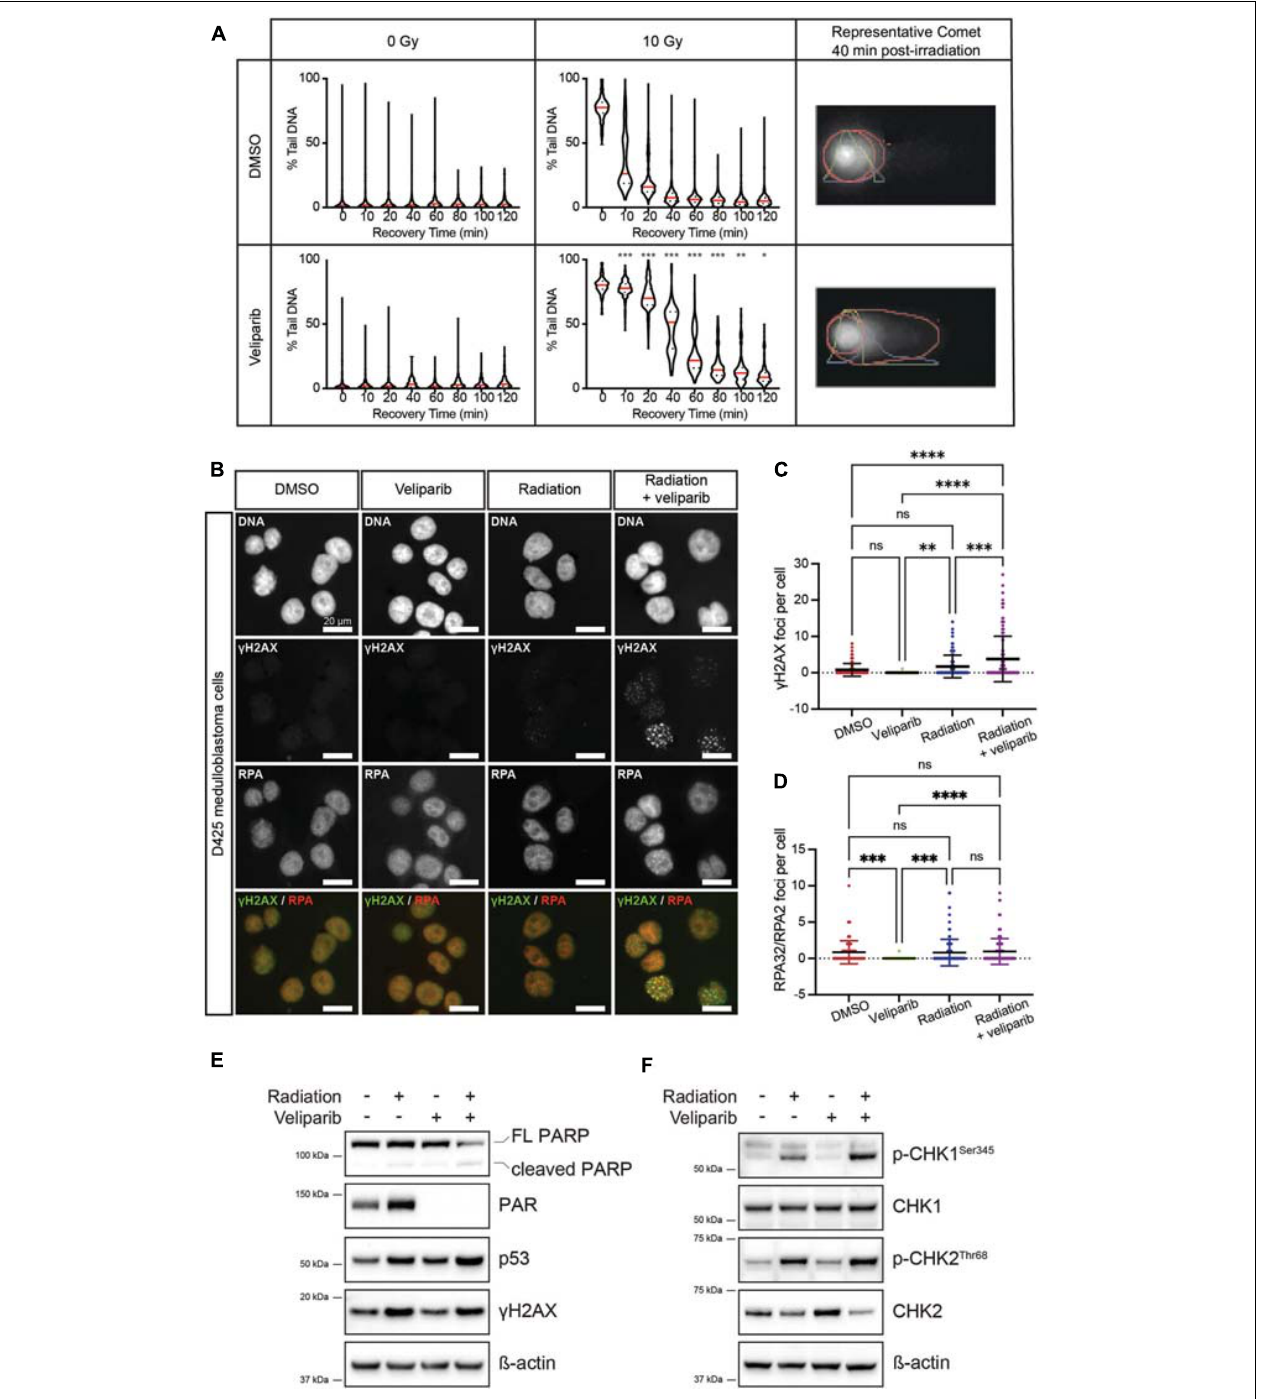
FIGURE 1 | PARP inhibition reduces the repair rate of radiation-induced DNA damage. (A) Comet assays were performed to detect DNA damage post-irradiation. Violin plots showing DNA damage (measured as the percent of DNA in the comet tail) for D425GiL medulloblastoma cells treated with DMSO or veliparib; and exposed to 0 or 10 Gy γ -radiation. Mean values for each timepoint are shown in red. * p < 0.05, ** p < 0.01, *** p < 0.001. Shown are representative images of comets with the head and tail regions outlined in red for each treatment at 40 min recovery time post-irradiation. (B) Representative fluorescent microscopy images of D425 medulloblastoma cells stained for DNA damage foci ( γ H2AX, green) and DNA repair foci (RPA32/RPA2, red), shown as single channel and composite images. Scale bar represents 20 µ m. (C,D) Quantification of γ H2AX foci (C) or RPA32/RPA2 (D) foci per cell. Each point is an individual cell and mean ± SD is shown. ** p < 0.01, *** p < 0.001, **** p < 0.0001, ns indicates not significant. (E,F) Immunoblots for the indicated proteins in D425GiL medulloblastoma cells treated with DMSO (–) or veliparib and exposed to 0 or 10 Gy γ -radiation. Blots are representative of two independent